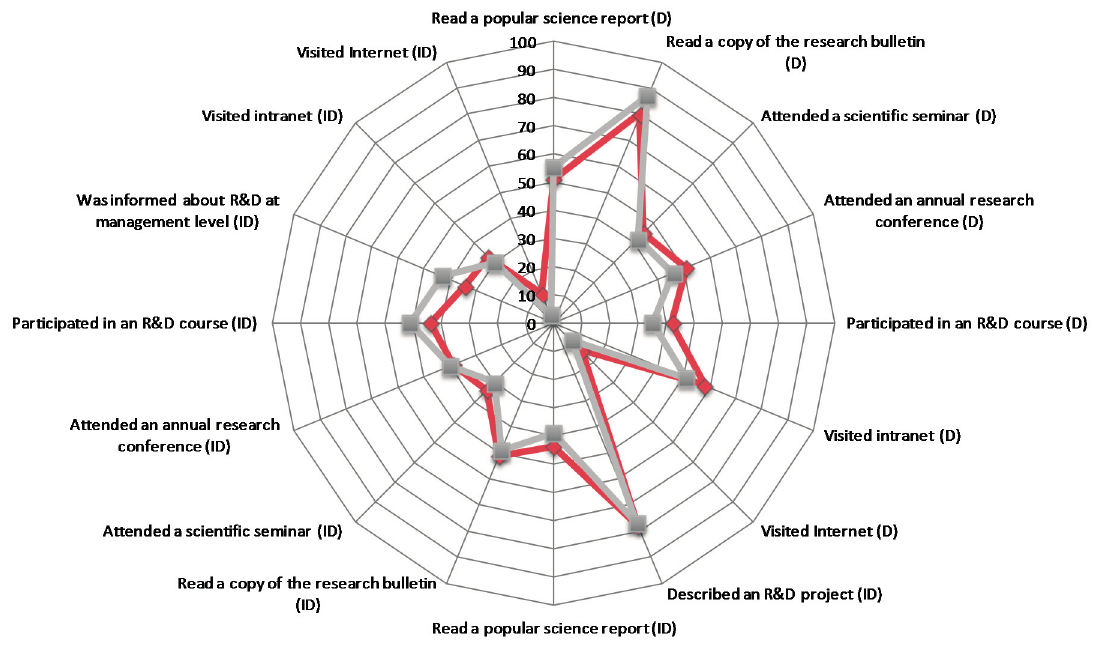
Note: 100 represents maximal